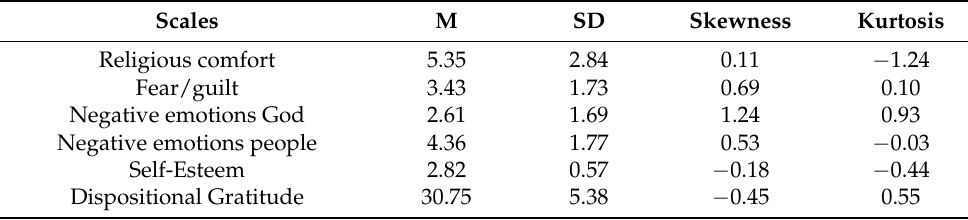
Table 1. Descriptive statistics for Religious Comfort and Strain Scale, Rosenberg Self-Esteem Scale, Gratitude Questionnaire ( N = 254).